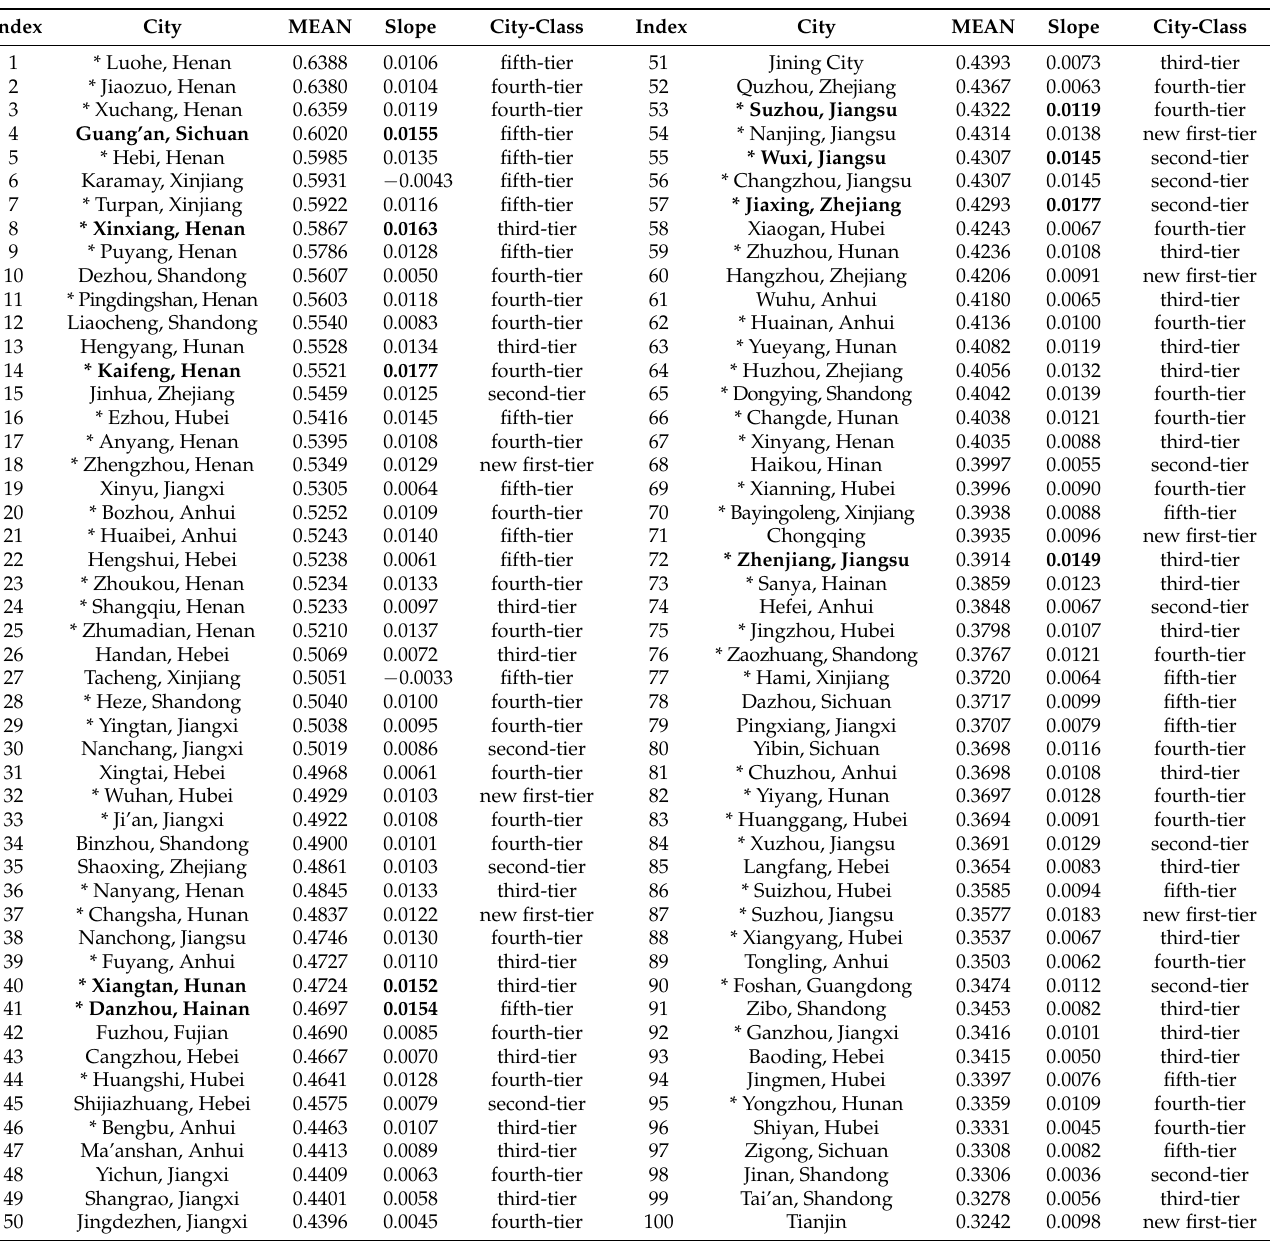
Table A1. Top 100 cities by average hazard (AH)